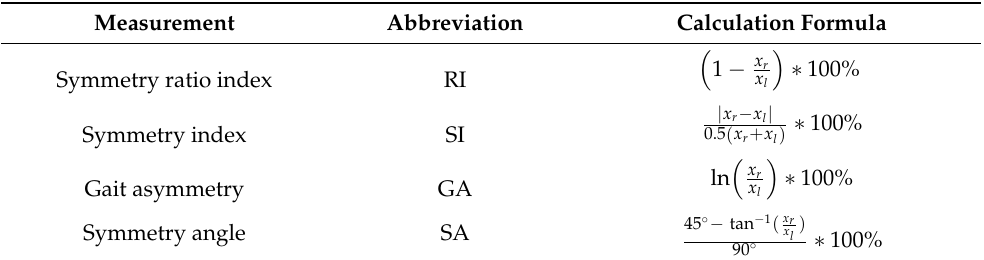
Table 1. Calculation formula of gait